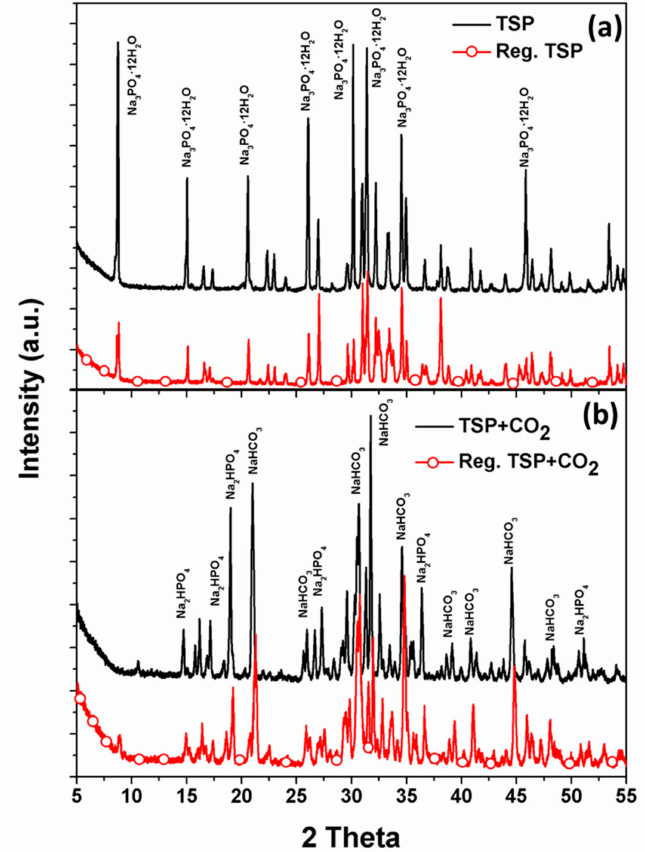
Figure 3. XRD spectrum of ( a ) pure TSP and regenerated TSP; ( b ) CO 2 -loaded pure TSP and CO 2 -loaded regenerated